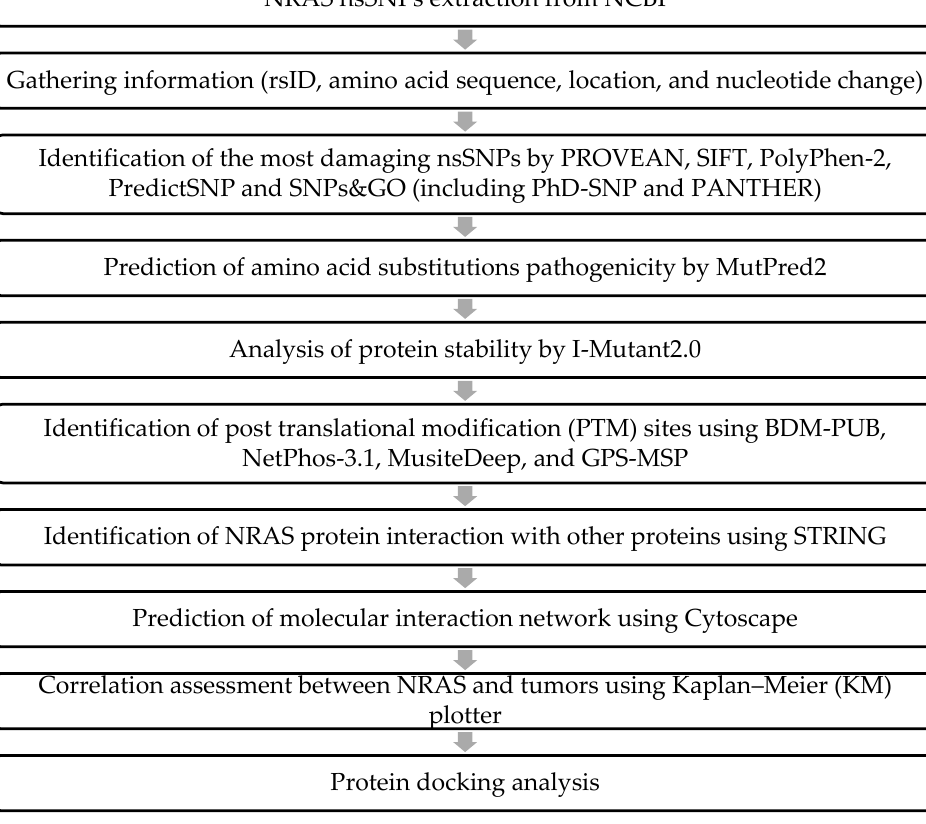
Figure 6. Diagrammatic representation of methodology.